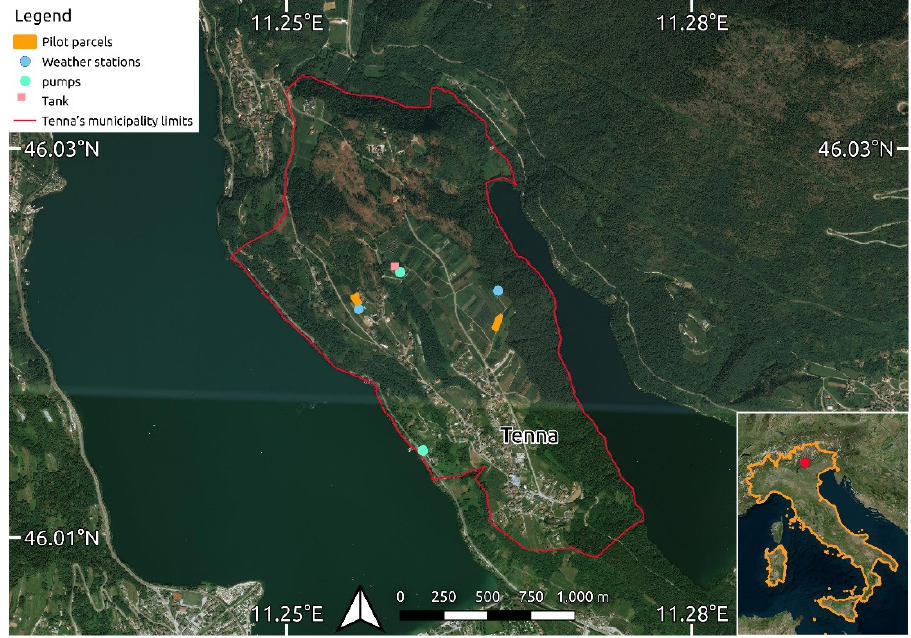
Figure 1. An experimental area of the project: Tenna, Trentino, Alto Adige, Italy. The east parcel, with an area of 0.21 ha, is cultivated with golden apples on rootstock M9, planted in 2015, with a planting distance of 0.80 × 3.00 m. The west parcel, with an area of 0.17 ha, is cultivated with Crimson Crisp apples on M9 rootstock, planted in 2014, with a planting distance of 0.80 × 3.50 m. Apples begin the vegetative cycle around March 20th. For both varieties, the fruits are harvested in the last week of September, and leaf fall occurs in the first days of